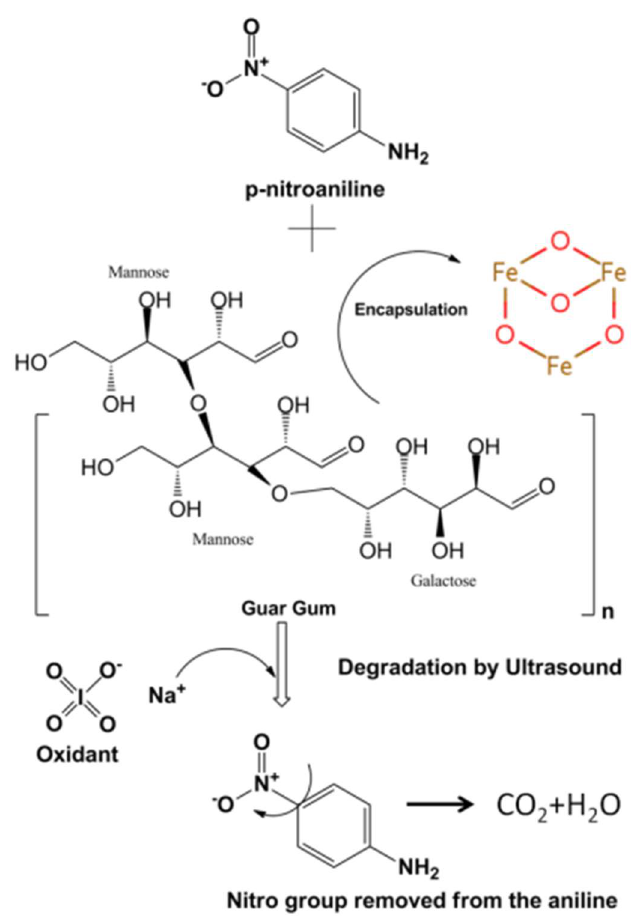
Figure 5. Proposed mechanism of the catalytic oxidation of ANB by FFGN .